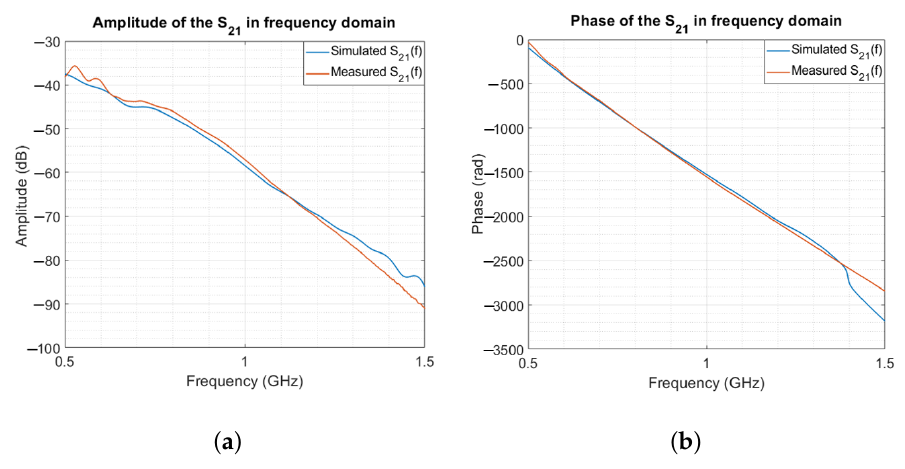
Figure 6. Simulated and measured S 21 in the frequency domain. ( a ) Amplitude. ( b ) Phase.